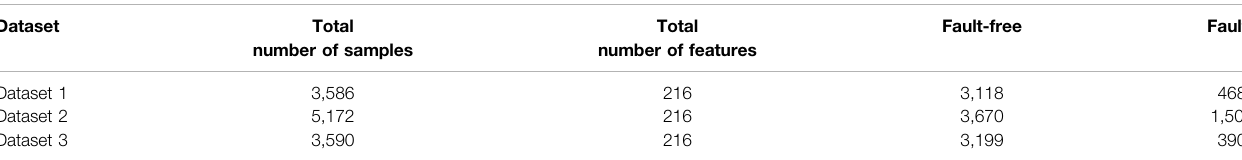
TABLE 3 | Dataset description.